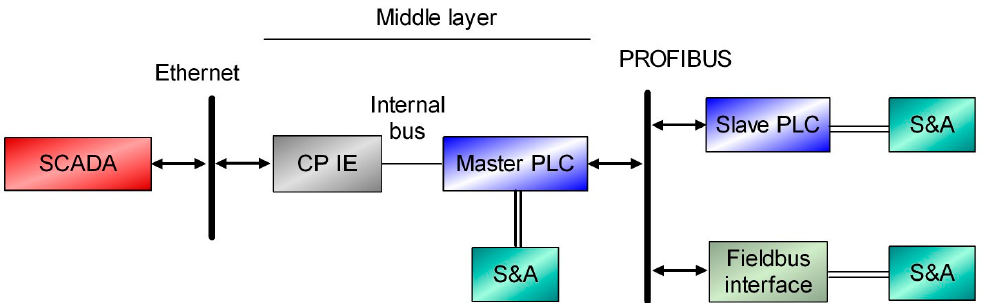
Figure 9. Block diagram of the proposed system.